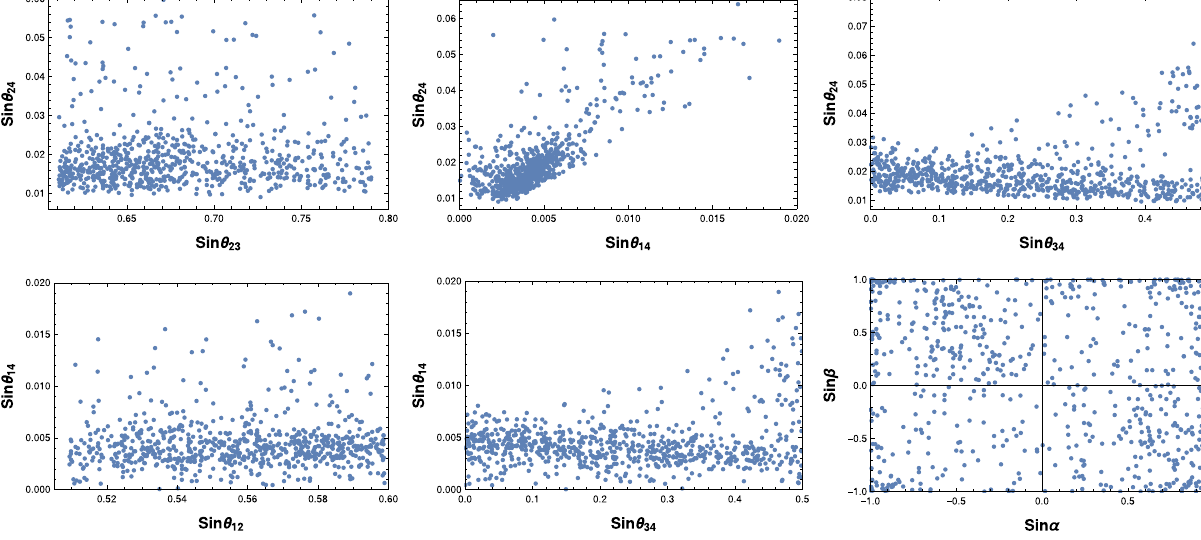
Fig. 8 Neutrino oscillation parameters in active-sterile sector for texture 3 zero case for